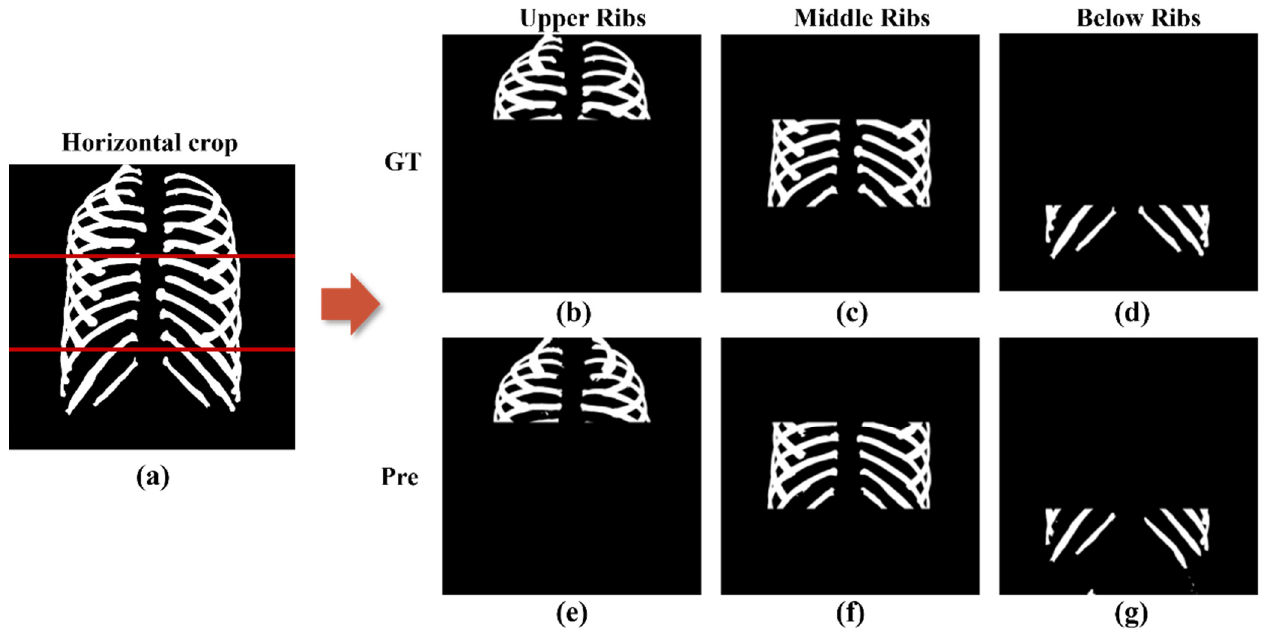
Figure 6. Horizontal crop image divided into superior, middle, and below based on the clavicle, heart, and lower organs: ( a ) Entire rib image before cropping; ( b ) Ground truth images of superior ribs; ( c ) Ground truth images of middle ribs; ( d ) Ground truth images of inferior ribs; ( e ) Predicted images of superior ribs; ( f ) Predicted images of middle ribs; and ( g ) Predicted images of inferior ribs. On average, precision, recall, sensitivity, and dice similarity coefficient values in the superior ribs were 92.69 ± 0.04%, 88.92 ± 0.88%, 88.92 ± 0.05%, 89.94 ± 0.04%; 94.11 ± 0.04%, 90.31 ± 0.90%, 89.88 ± 0.05%, 91.01 ± 0.04% in the middle ribs; and 93.45 ± 0.04%, 83.53 ± Table 4. Five-fold cross validation results of the superior, middle, and inferior ribs. Precision (%) Recall (%)